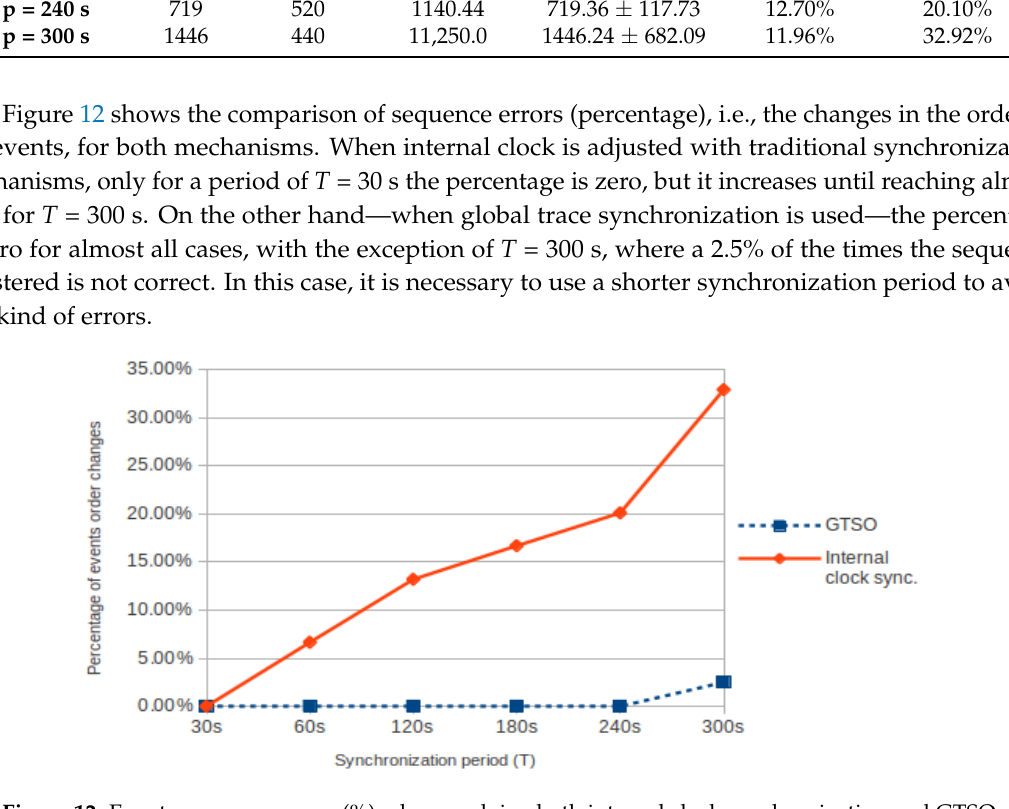
Figure 12. Events sequence errors (%) when applying both internal clock synchronization and GTSO.